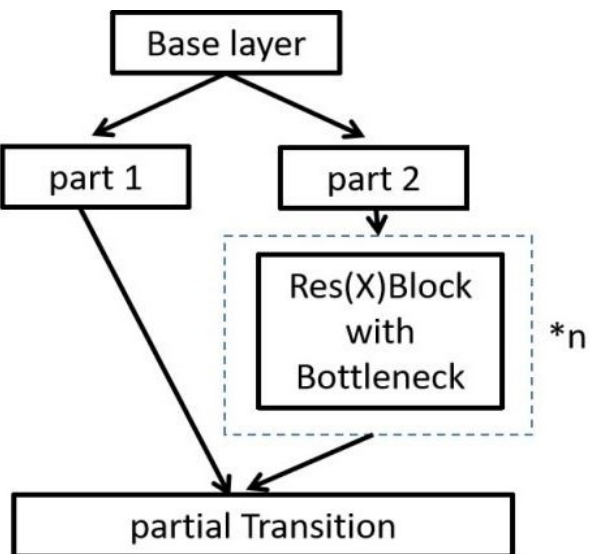
Figure 6. The structure of CSPNet.